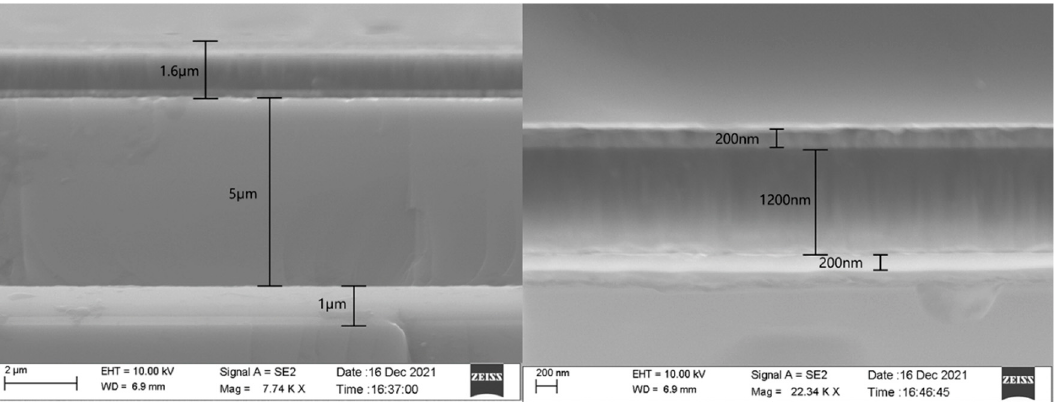
Figure 10. SEM image of a thin-film vibration layer and PMUT piezoelectric thin-film layers of